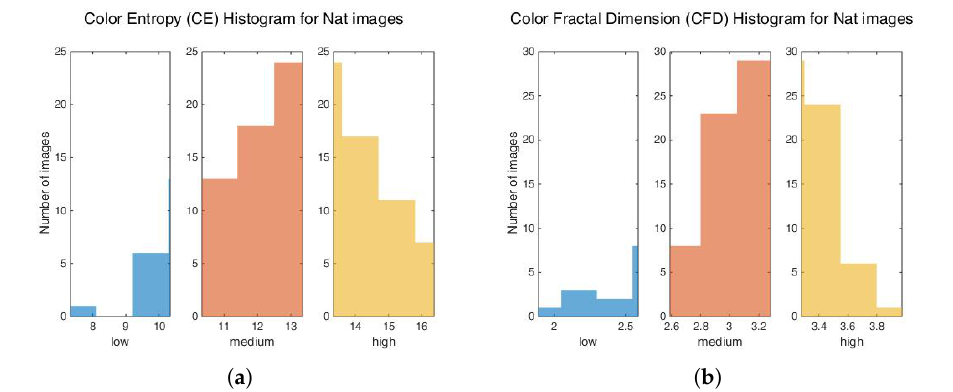
Figure 2. Color Entropy Histogram ( a ) and Color Fractal Dimension ( b ) for Nat images regarding complexity levels. Adapted from Ref. [48].